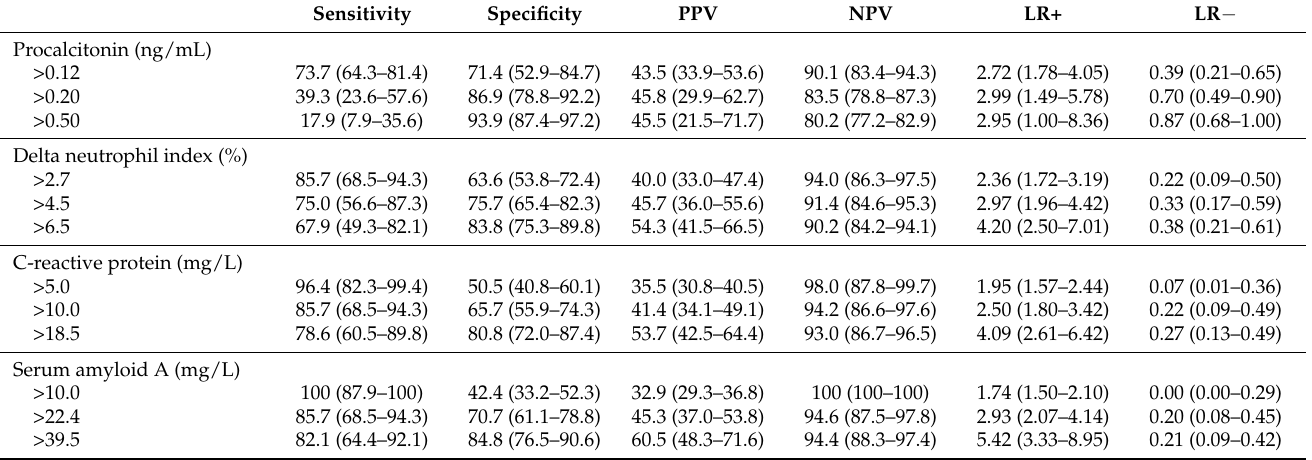
Figure 3. Receiver operating characteristic curves of procalcitonin, delta neutrophil index, C-reactive protein, and serum amyloid A for ( A ) all patients, ( B ) patients with neutropenia, and ( C ) patients without neutropenia. Table 2. Performance of procalcitonin, delta neutrophil index, C-reactive protein, and serum amyloid A for the diagnosis of infection at various cutoff values (mean and 95% confidence intervals).